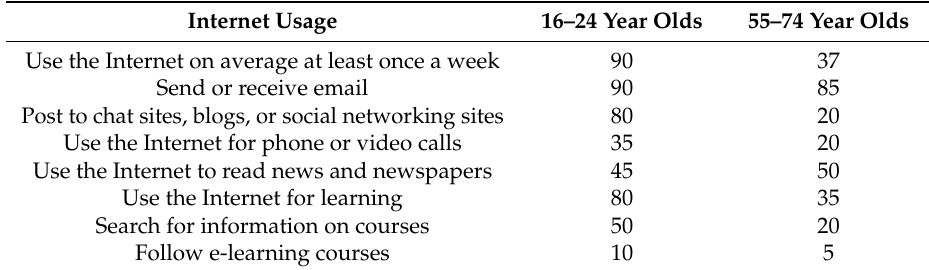
Table 1. Internet use by age group; percent in the EU27 member states